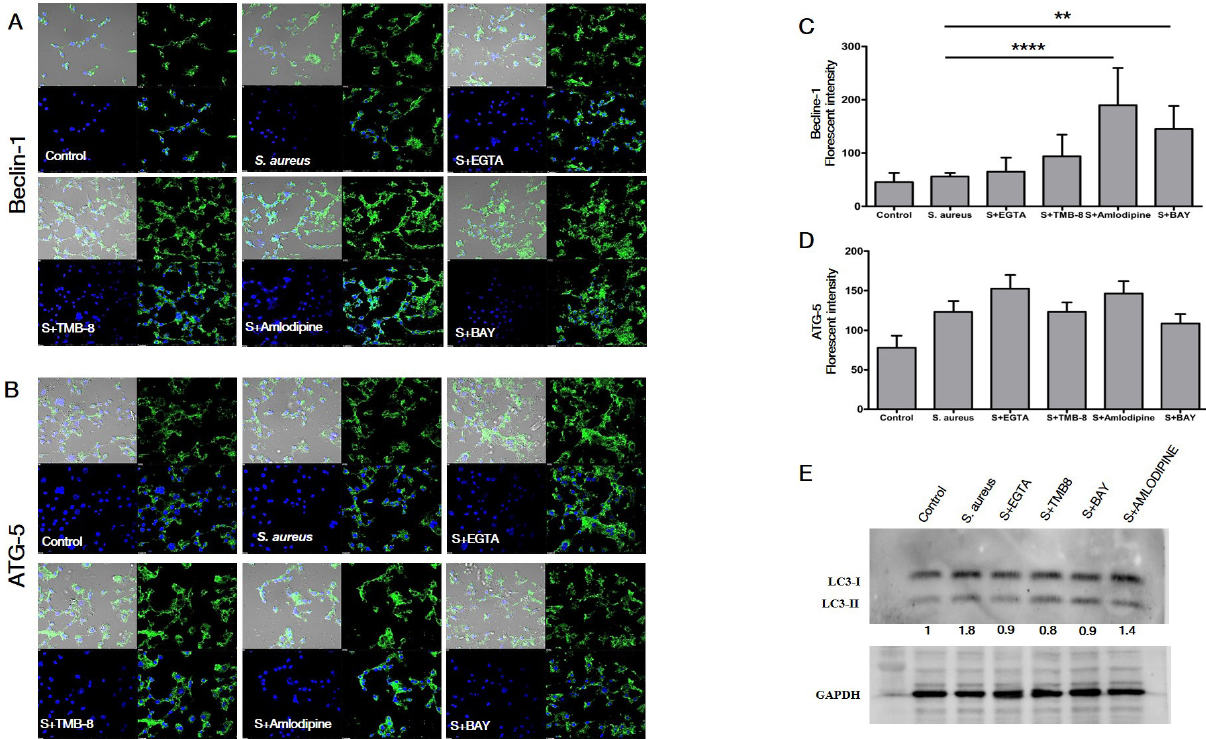
Figure 3: Calcium differentially regulates expression of autophagy pathway molecules in macrophages during S. aureus infection. Murine J774 macrophages were incubated with either EGTA or TMB-8 or BAYK8664 or amlodipine for 2h followed by infection with 20 MOI S. aureus infection for 2h. Cells were processed and stained with FITC tagged antibody to Beclin-1 (Panel A) or ATG5 (Panel B). Images were captured under a confocal microscope. Confocal imaging was performed with Nikon C2 laser scan confocal microscope with 60x magnification. Data represent the mean ± SD of 3 independent experiments. S indicates S. aureus infection. Bar graphs adjacent to confocal images show fluorescence intensity of Beclin-1 (Panel C) and ATG-5 (Panel D), respectively. For Panel C (Beclin-1), P-value between S. aureus vs S. aureus + Amlodipine is p<0.0001; S. aureus vs S. aureus + BAYK8664 is p=0.0017. For Panel E, J774 macrophages were incubated with either EGTA or TMB-8 or BAYK8664 or amlodipine for 2h followed by infection with 20 MOI S. aureus infection for 2h. Cytoplasmic extracts were Western blotted for the levels of LC3-I/II. The blot for GAPDH represents loading